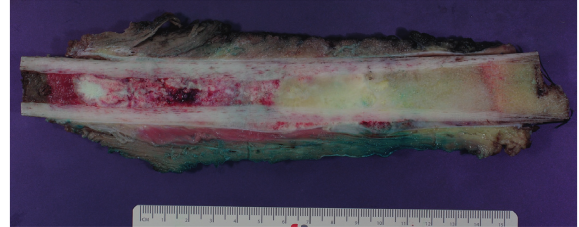
Figure 4: Macroscopy of femoral osteosarcoma with two cuts, one horizontal and one